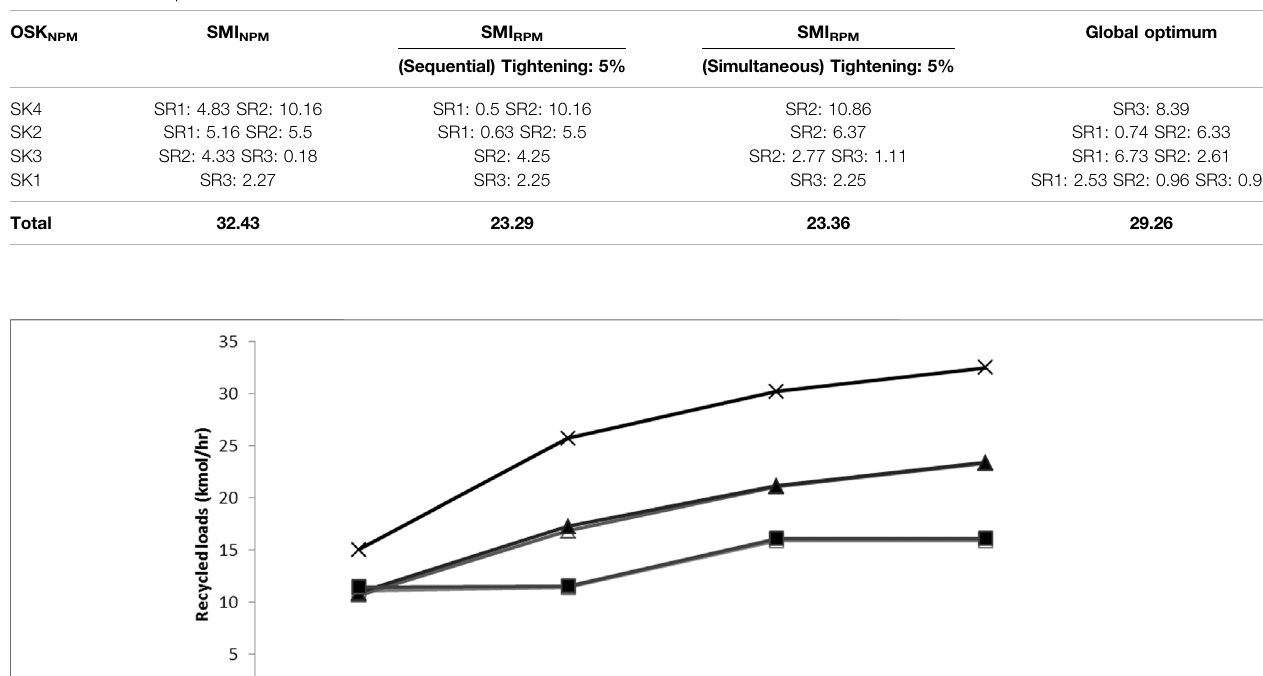
TABLE5| SMI NPM ,SMI RPM andglobaloptimumresultsforthecasestudy-2.Foreachsinktherespectivesourcesrecyclingtothatsinkareshown.Theresultsforthesingle- variable sequential and multi-variable simultaneous recycling maximisation approaches at each process sink selection step are reported at their optimal tightening constant values. All reported values refer to kmol/hr.